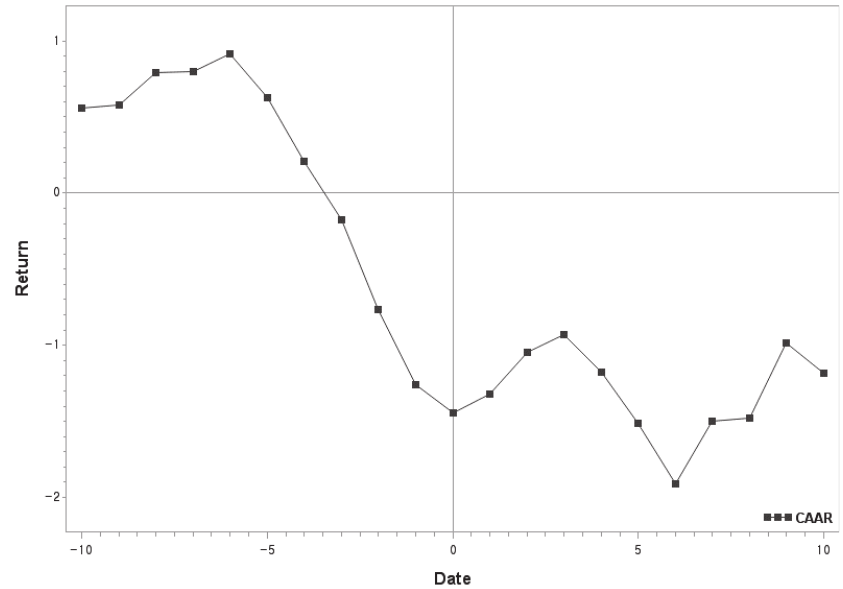
<Figure 3> CAAR for ± 10 Days from Announcement of a Celebrity